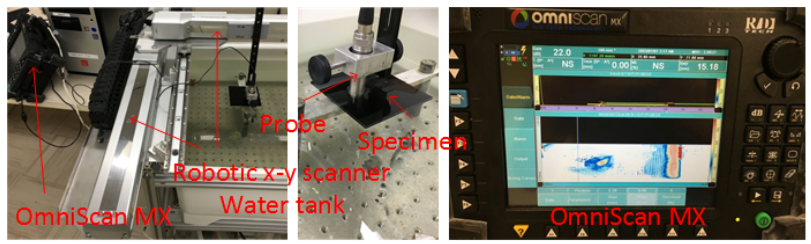
Figure 6. UT experimental set-up.